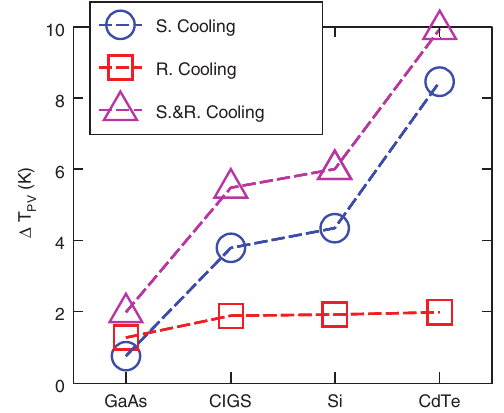
Figure 8: Simulated temperature reduction obtained by different cooling schemes (S. Cooling: selective-spectral cooling; R. Cooing: radiative cooling; S.&R. Cooling: selective-spectral cooling and radiative cooling combined). The simulation assumes that the wind speed is approximately 0.5 m/s giving an effective convective coef- ficient h = 10 W/(K m 2 ), conductive heat transfer only at the module edges through metal frames is neglected, and the ambient tempera- ture T and solar irradiance are 300 K and 1000 W/m 2 , respectively. A The atmospheric transmittance data are for New Delhi in spring, with perceptible water vapor (PWV) = 18 mm. © 2017 IEEE. Reprinted, with permission, from